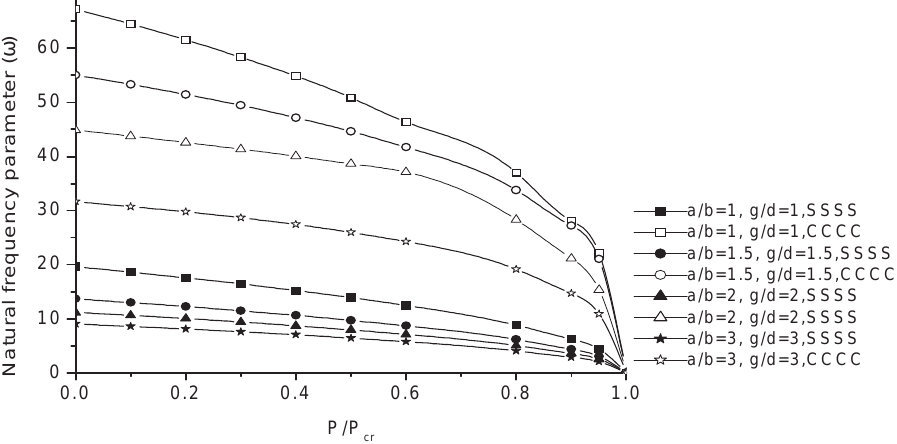
Fig. 16. Effect of aspect ratios on vibration frequency for stiffened plates with cutouts having one central longitudinal stiffener ( δ = 0.1 and γ = 10). a/b = 1, 1.5, 2, 3 and g/d = 1, 1.5, 2, 3.